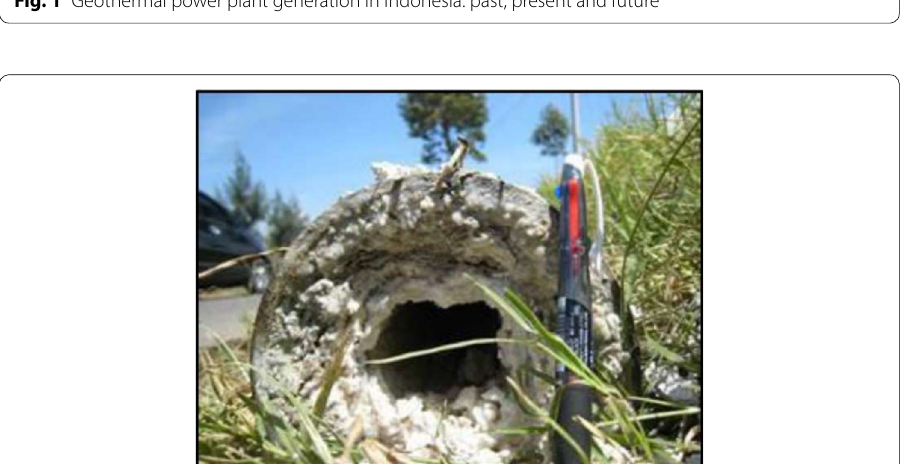
Fig. 2 Clogged pipe at Dieng Geothermal Power Plant despite using acidification to prevent silica scaling (Pambudi et al.